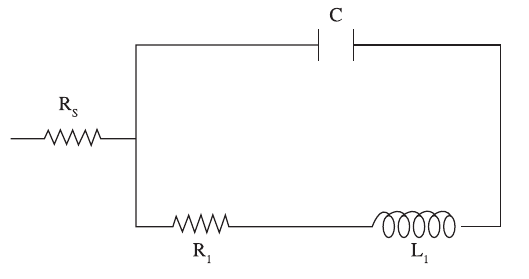
Figure 11. Equivalent circuit obtained of fitting the EIS data of Figure 10b; Rs(Q [R (Q [R 1 1 2 3 spectra. The EC used to describe the EIS spectrum in 0.01 M NaF